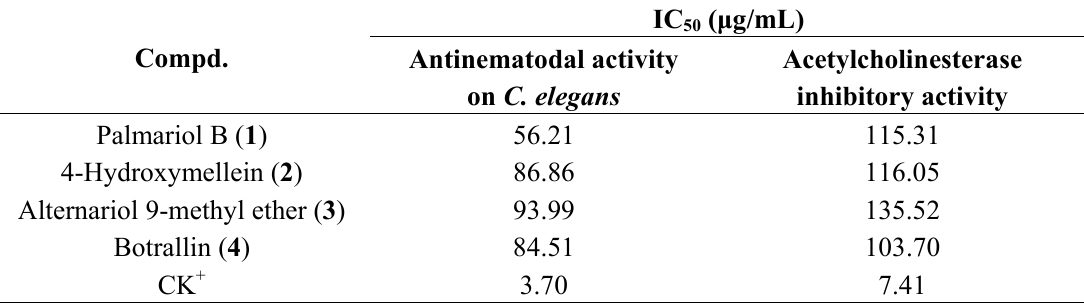
Alternariol 9-methyl ether ( 3